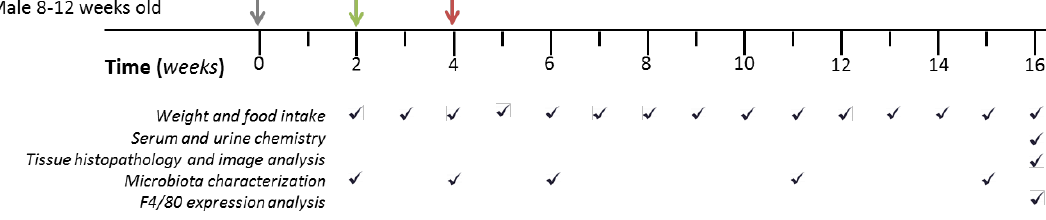
Figure 1. Study design and sampling scheme.